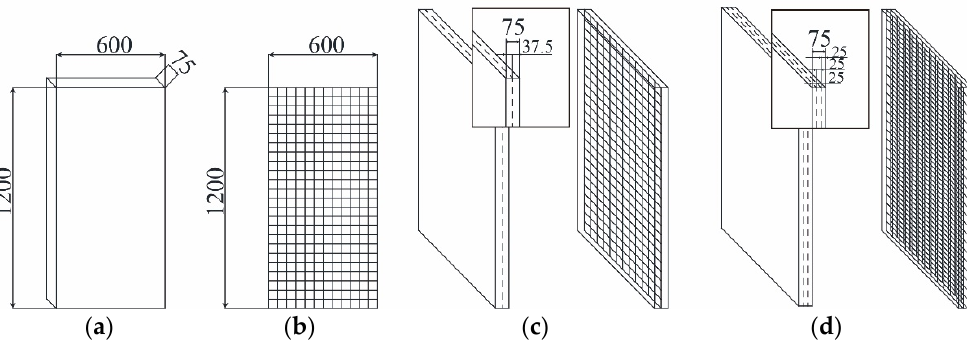
Figure 1. Specimen of carbon fiber grid reinforcement panel (Unit: mm). ( a ) Concrete panel. ( b ) Carbon fiber grid. ( c ) One layer. ( d ) Two layers. Table 1. Experimental